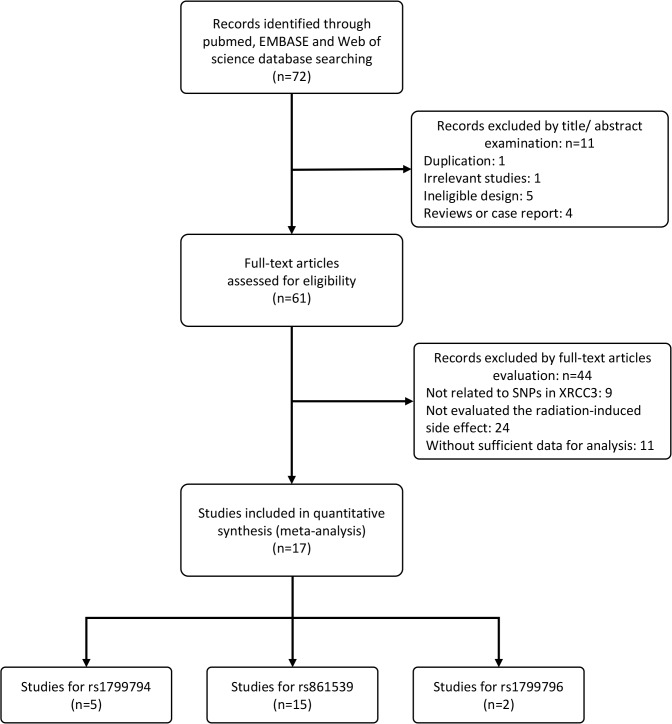
Flow diagram of the literature review process.